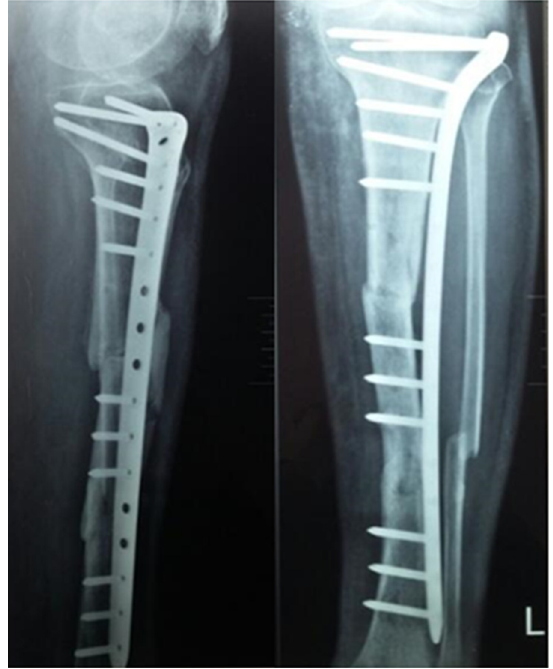
Figure 5. AP and Lat radiographs showing healed proximal and distal fractures 20 weeks